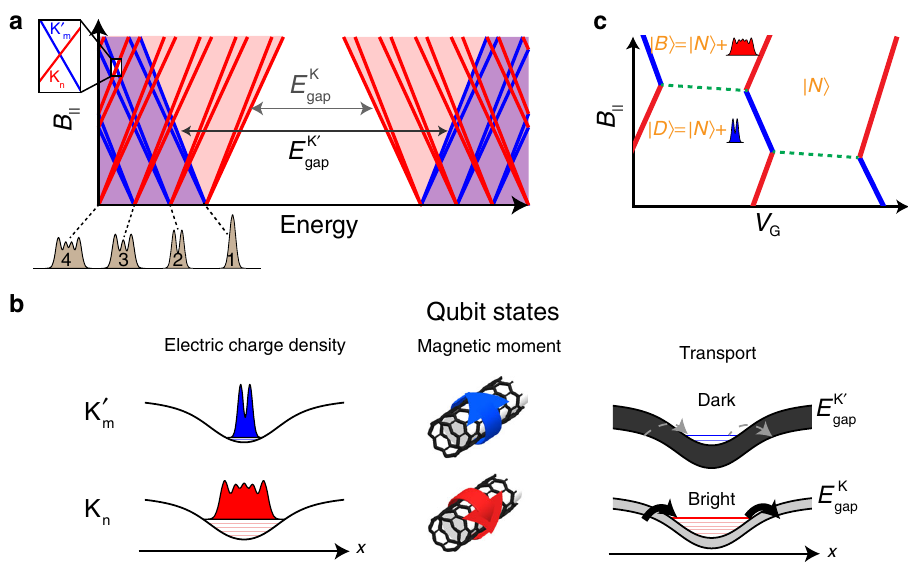
Fig. 1 A qubit based on the natural wavefunctions in a carbon nanotube. a Single particle energy spectrum of a single quantum dot in a carbon nanotube, as a function of magnetic fi eld parallel to the tube axis, B || . Each spatial wavefunction (gray illustrations, bottom) has at B || = 0 a 4-fold spin ( ↑ , ↓ ) and valley ( K − red, K ′ − blue) degeneracy, which is lifted at fi nite B || with slopes given by the spin and orbital magnetic moments ± μ spin ± μ valley . B || also modi fi es the bandgap of the two valleys: E K decreases and E K 0 increases with B || (gray arrows). The intersection of two levels at fi nite B || (inset) is used as the basis of gap gap our qubit. b The two intersecting levels (referred to as K n , K 0 ) differ in three quantities: Since the K n state is a much higher bound state in the con fi nement m potential than the K 0 state, it is spread more along the nanotube (left). The K n and K 0 states originate from opposite valleys with opposite magnetic m m moments due to opposite directions of electron motion around the nanotube circumference (center). The barriers of the dot are formed by the nanotube bandgap, which at fi nite B || is different for the two valleys (see panel a ), making the tunneling from the leads into the K n state much faster than to the K 0 m state (bright/dark, right panel). c Charge stability diagram, obtained by adding the charging energy to the energy spectrum in the inset in panel a . Coulomb blockade peaks zig-zag between charging of the two valleys (red/blue). The triple point used in the experiment is between the N j i state, having N holes, and the D j i and B j i states, which are obtained by adding either a K n hole (red) or a K 0 hole m D j i ¼ N j i þ K 0 , both having N + 1 holes. Within the Coulomb m valley there should be a boundary line separating the B j i and D j i ground states (dashed green) along which the ground state changes its last occupied wavefunction while maintaining the total charge in the dot fi xed. This line will however be invisible in transport, as the system is in Coulomb blockade.